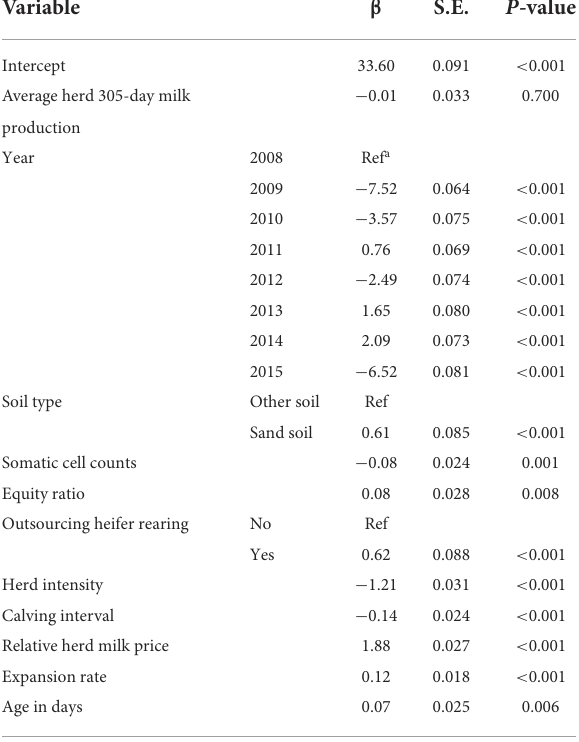
TABLE 5 Results of the final reduced linear mixed model on the association between income over feed cost per 100kg milk ( e ) and average herd 305-day milk production (and other herd variables) based on data from 1,664 Dutch herds.